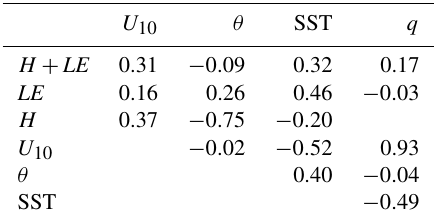
Table 3. Same as Table 1 but at 18:00UTC on 7